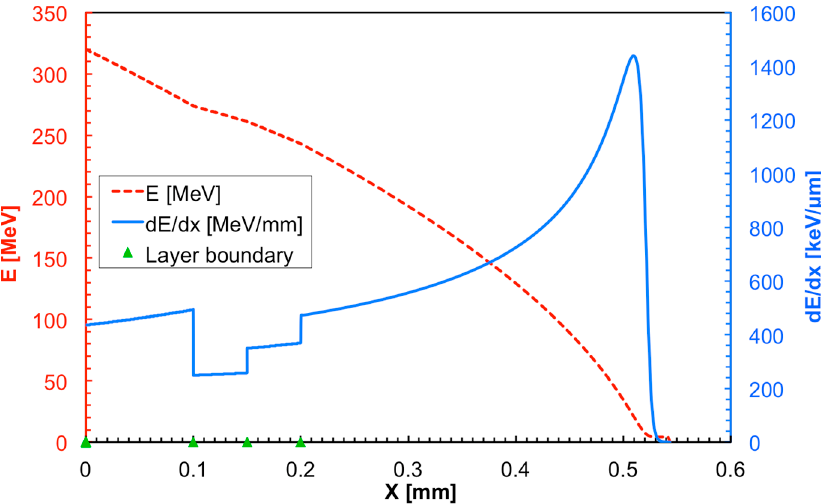
Figure 11. Energy loss profile in the telescope for an impinging 16 O ion with 20 MeV/amu kinetic energy.